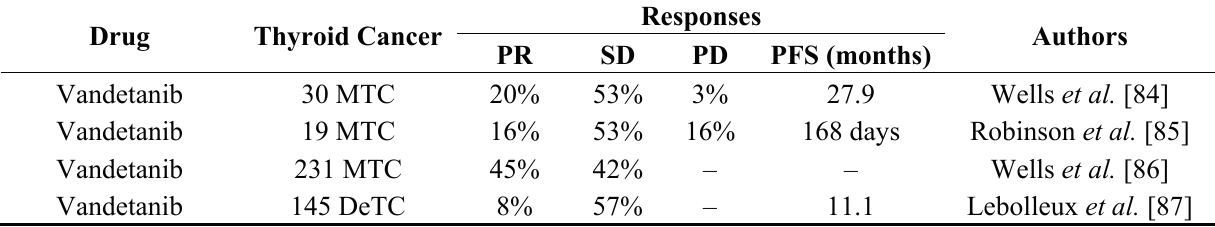
Table 3. Clinical trials of Vandetanib in patients with thyroid